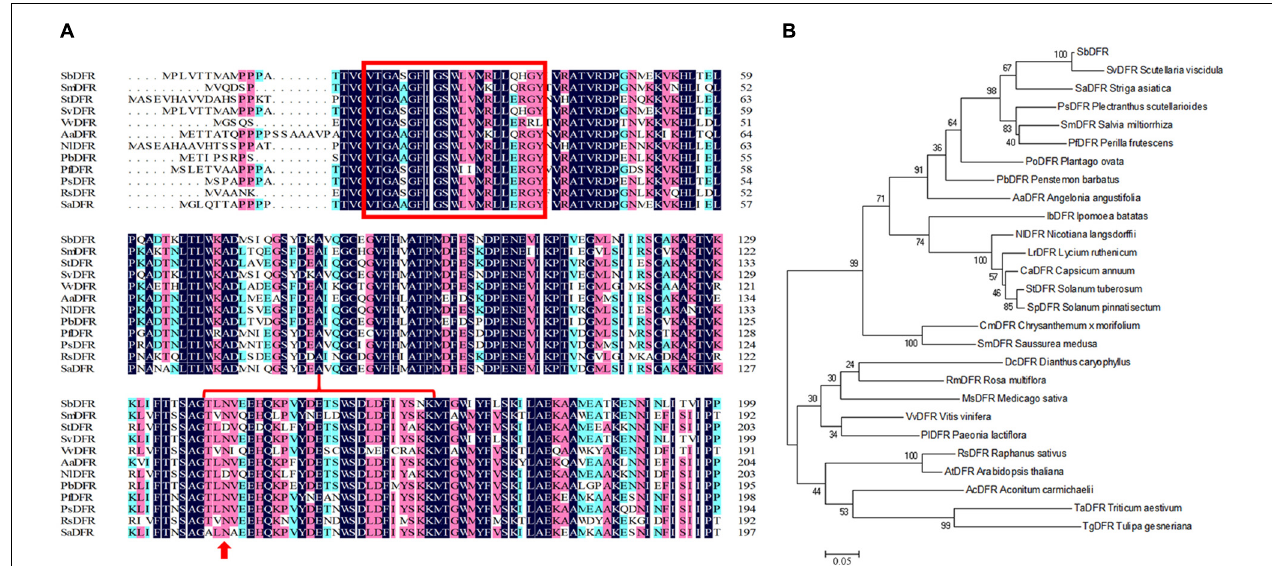
FIGURE 7 | Phylogenetic and multiple alignment analyses of the deduced amino acid sequence of the SbDFR protein from Scutellaria baicalensis and other species. (A) Multiple alignment of the proteins from selected species. The NADPH binding domain and substrate specific binding domain are marked by the red box and red brace, respectively, and the site marked by the red arrow is the amino acid residue influencing enzyme substrate specificity. (B) Phylogenetic analysis of SbDFR proteins from S . baicalensis and other selected species.